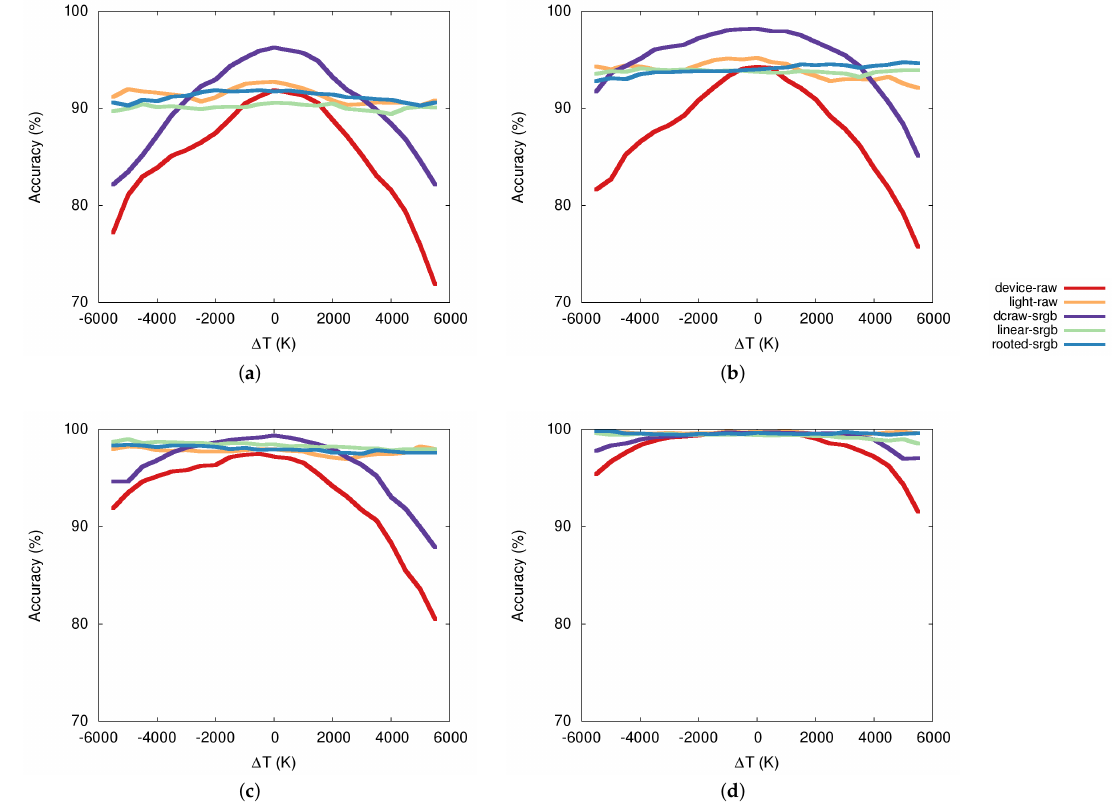
Figure 8. Accuracy behavior with respect to the difference ( ∆ T ) of daylight temperature between the training and the test: ( a ) setsVGG-M-128; ( b ) AlexNet; ( c ) VGG-VD-16; ( d )